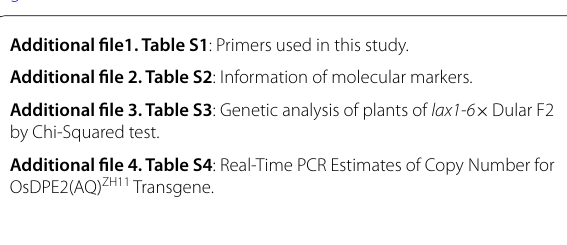
Additional file 2. Table S2 : Information of molecular